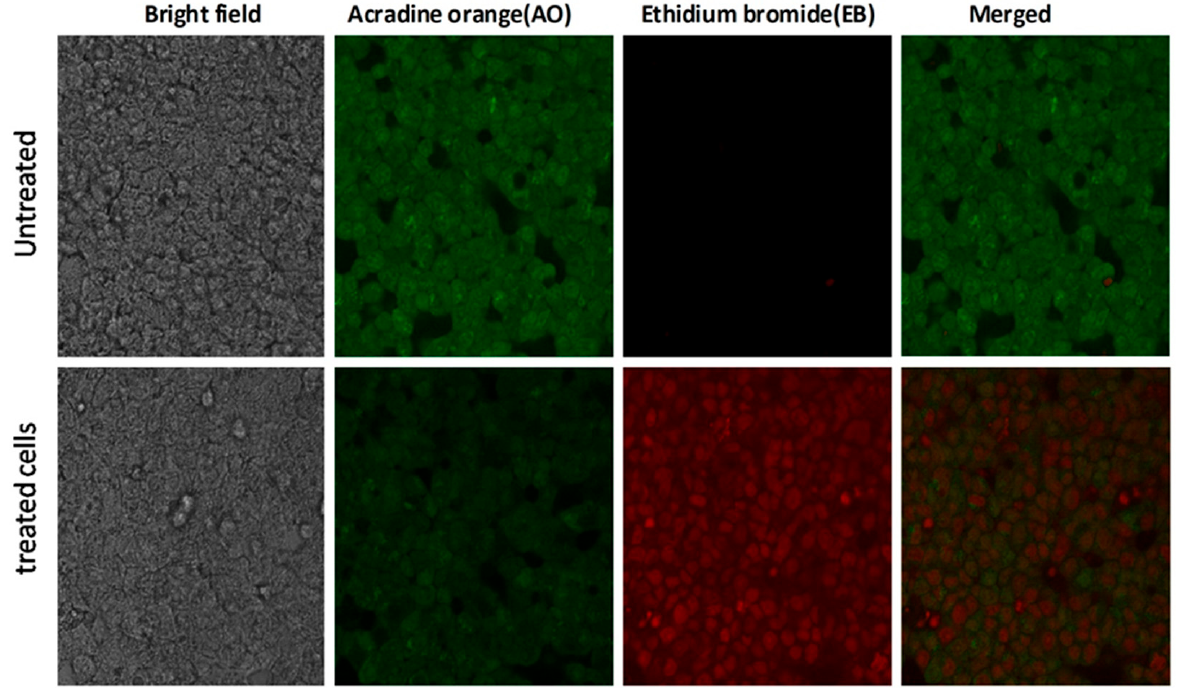
Figure 7. S. lappa n-butanol root extract-induced apoptosis. Dual staining study of HepG2 cells by acridine orange (AO) and ethidium bromide (EB) (AO represents viable cells and EB represents dead cells). Untreated and treated with n-butanol extract (56.76 µ g/mL) representing the changes in nuclear morphology of cells (the images were captured at 40 × magnification).